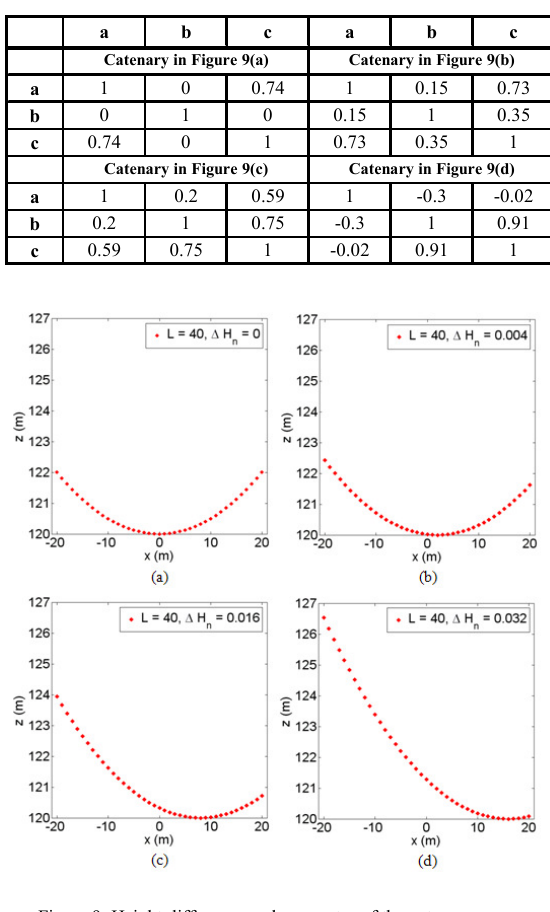
The correlation between the b and c parameters is a function of both ∆H n and L. It can be seen in Figure 10 that as ∆H n increases, the correlation between b and c increases (as does the catenary asymmetry). However, increasing L has the effect of lowering the correlation.